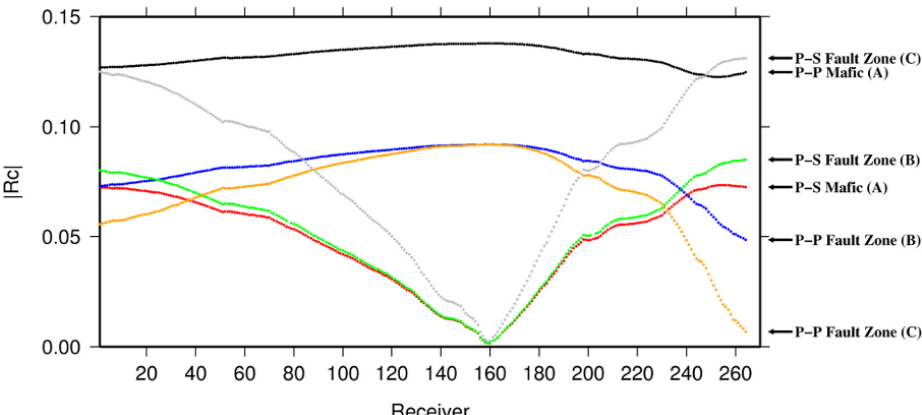
Fig. 10. Comparison of magnitude of reflection coefficient ( | Rc | ) for different reflecting boundaries. Geometry of boundary as for reflec- tion R1 (strike 55 ◦ and dip 55 ◦ ) and properties of rocks as defined in Table 4.